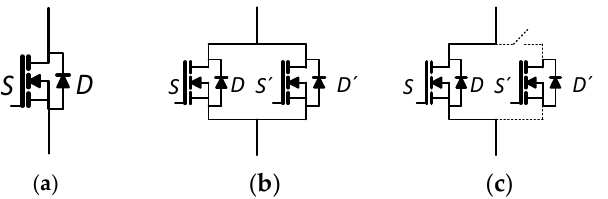
Figure 4. Reliability structures in MOSFET: ( a ) A single MOSFET system in serial; ( b ) Redundant system active in parallel with two MOSFETs; ( c ) Redundant system passive in parallel with two MOSFETs.